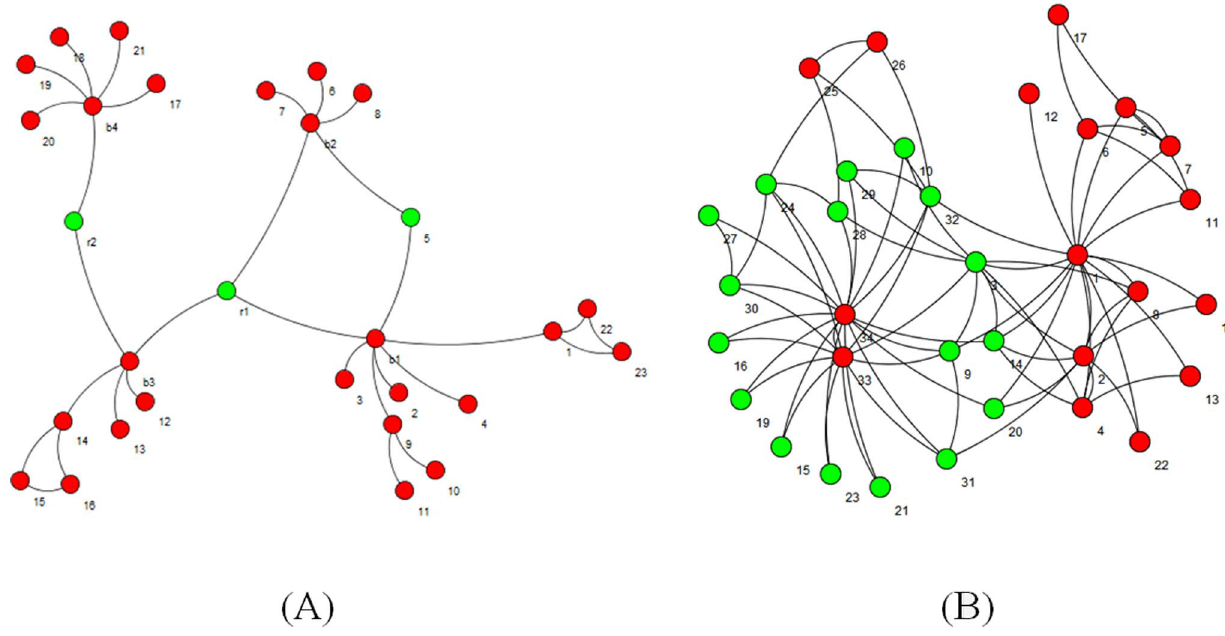
Figure 4. Green vertices are the most creative elements realized by equation (1) in a network which is illustrated Figure 2 (A) and in Zachary ’ s karate club network (B).